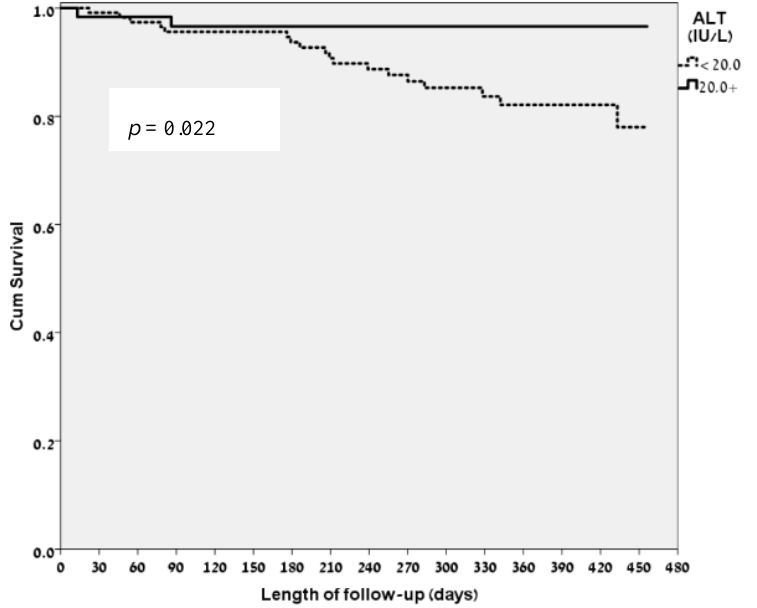
Figure 1. Kaplan-Meier survival curve according to ALT, Alanine Aminotransferase levels on admission: below and over 20 IU/L.